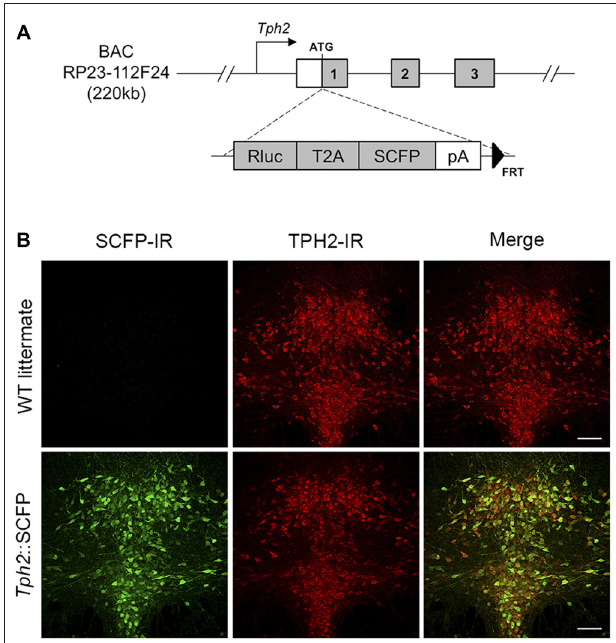
FIGURE 1 | Generation and characterization of Tph2 ::SCFP (TSC) transgenic mice. (A) Scheme of BAC construct used for generation of the TSC transgenic mouse line. The Rluc-T2A-SCFP cassette was inserted at the ATG site of the Tph2 gene in an RP23-112F24 mouse BAC. The modified construct was used for creation of a transgenic mouse line, allowing super cyan fluorescent protein (SCFP) and Renilla luciferase expression under Tph2 promoter. (B) Confocal images of SCFP and TPH2 immunoreactivity in 70 µ m coronal sections of the dorsal raphe nucleus (DRN) in wild type littermates (upper panel) and TSC transgenic mice (lower panel). SCFP expression was detected in the DRN of TSC mice with an anti-GFP/CFP antibody (shown in green; left). No signal was seen in wild type littermates. TPH2 expression was detected with an anti-TPH2 antibody (red; middle). In TSC mice, the SCFP signal co-localizes with virtually all TPH2-positive neurons in the DRN (yellow in the sum of both channels; right). IR, immunoreactivity. Scale bar: 100 µ m.